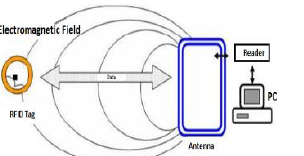
Figure 2: RFID Deployed System Overview